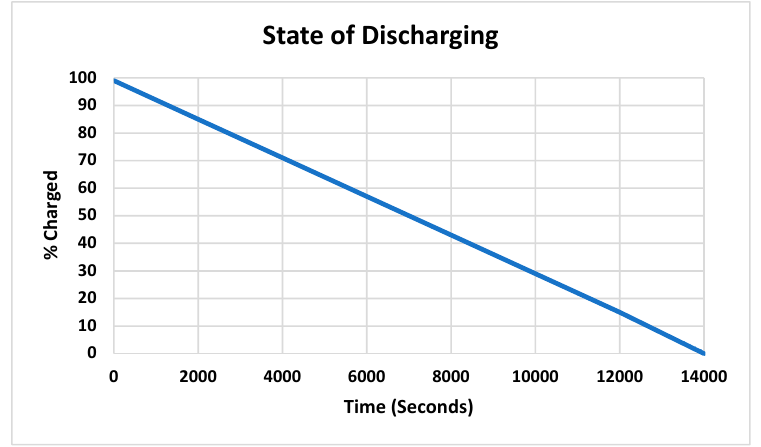
Figure 26. Discharging/State of Charge.